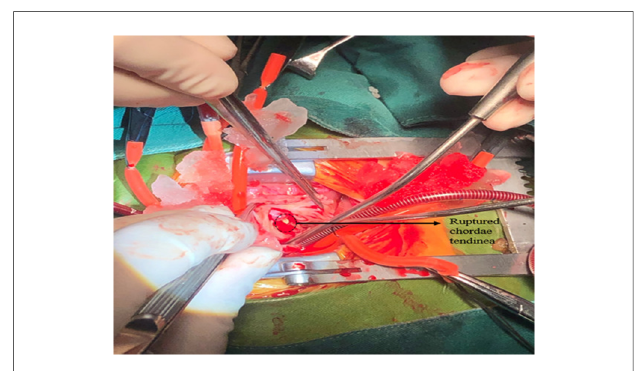
FIGURE 3 Surgical fi ndings. A ruptured chorda of the anterior lea fl et of TV was found, and the other head of papillary muscle was found near the moderator band. No ischemic changes were observed. TV, tricuspid